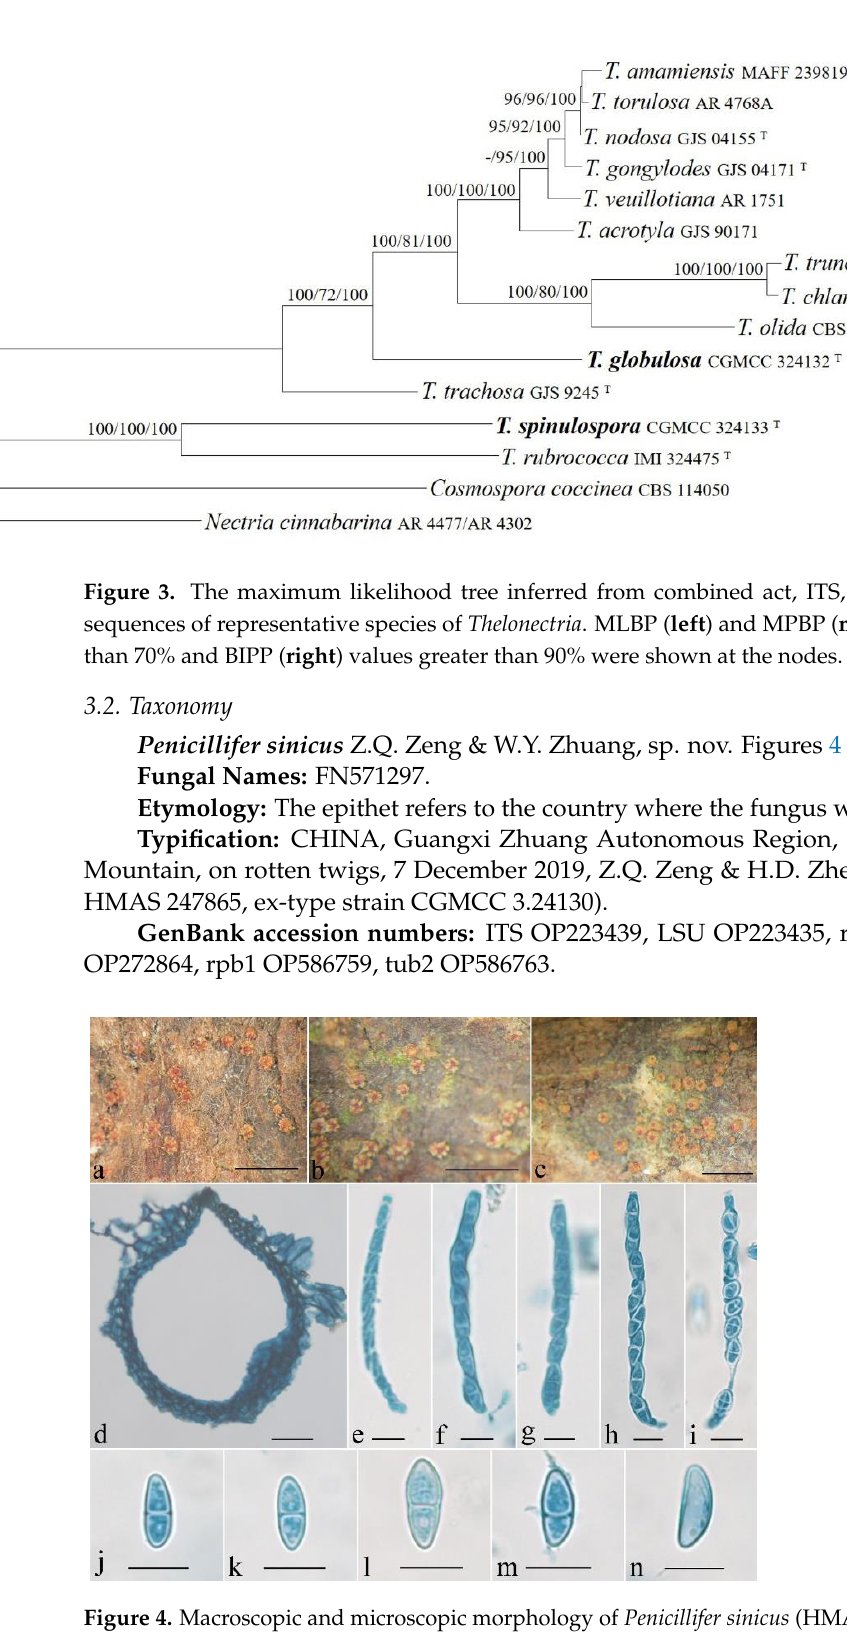
Figure 2. The maximum likelihood tree inferred from combined ITS, LSU, and tub2 sequences of representative species of Pseudocosmospora . MLBP ( left ) and MPBP ( middle ) values greater than 70% and BIPP ( right ) values greater than 90% were shown at the nodes.